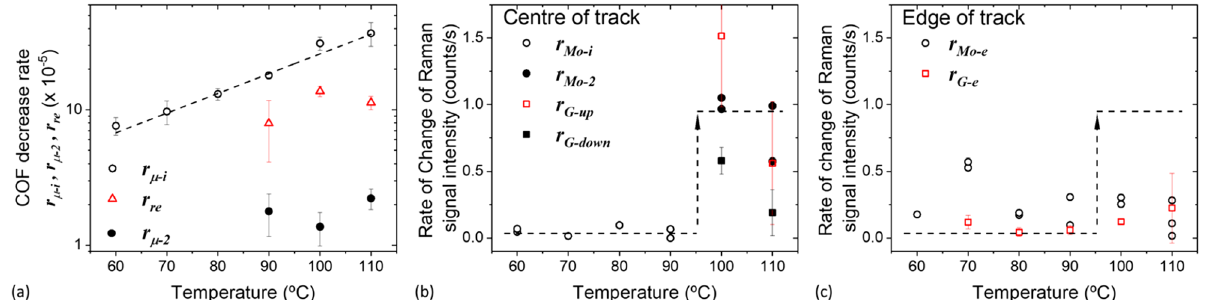
Figure 7. Effect of temperature on: ( a ) rates of change of coefficient of friction (absolute value) and ( b ) rates of change of Raman signals at the centre and ( c ) edge of the track. The dashed lines are for guidance